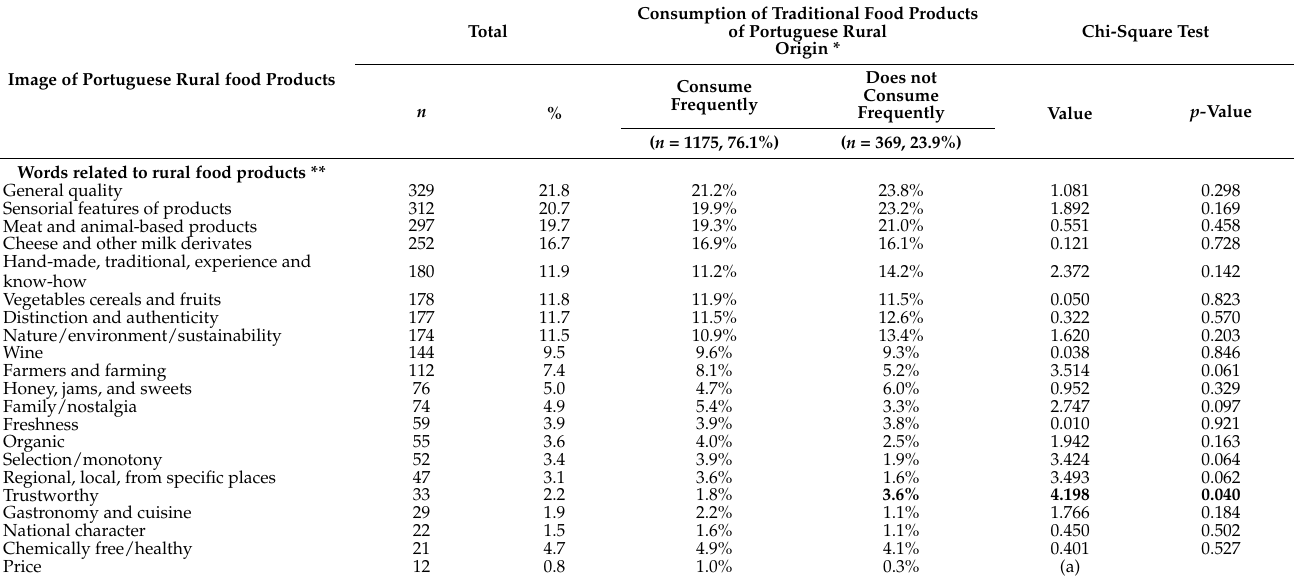
Table 5. Consumers’ images of Portuguese rural provenance